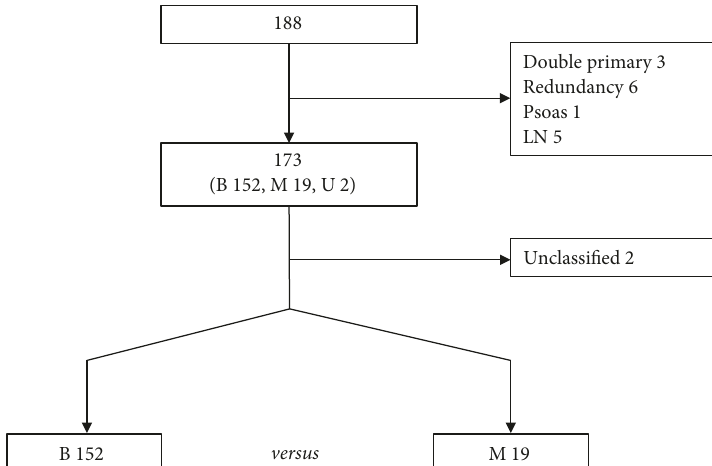
Figure 2: Flow diagram outlining the enrollment protocol in COMETE cohort. PC: pheochromocytoma; PG: paraganglioma; M: malignant; B: benign; U: unclassified; LN: lymph node.